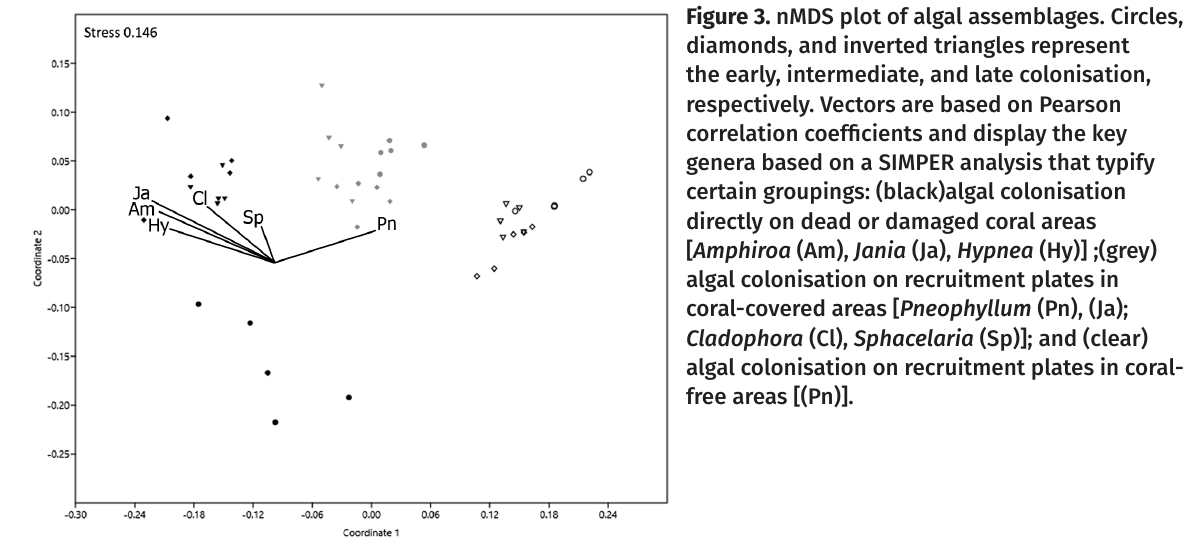
Table III. Permutational multivariate analysis of variance (PERMANOVA). Comparison of the average percentage of colonised algal coverage among the factors: treatment (scraped coral (C)), recruitment plates in the region with coral (P[c]) and without coral (P [wc]), and time (early, intermediated, and late). Degrees of freedom (df), sum of squares (SS), and mean squares (MS). *Significant results in bold. df